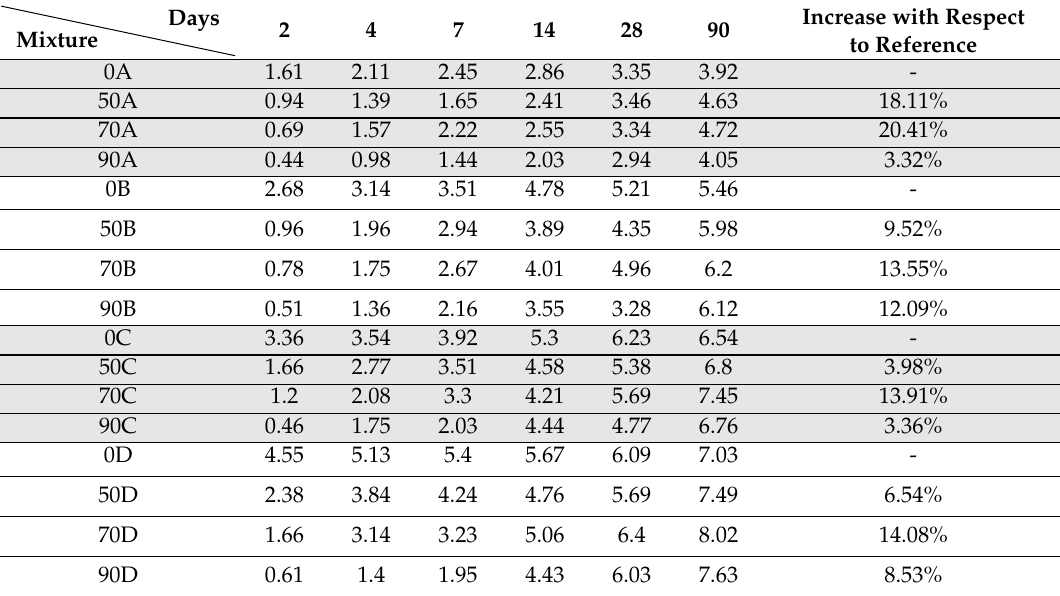
Table 4. Flexural strength results